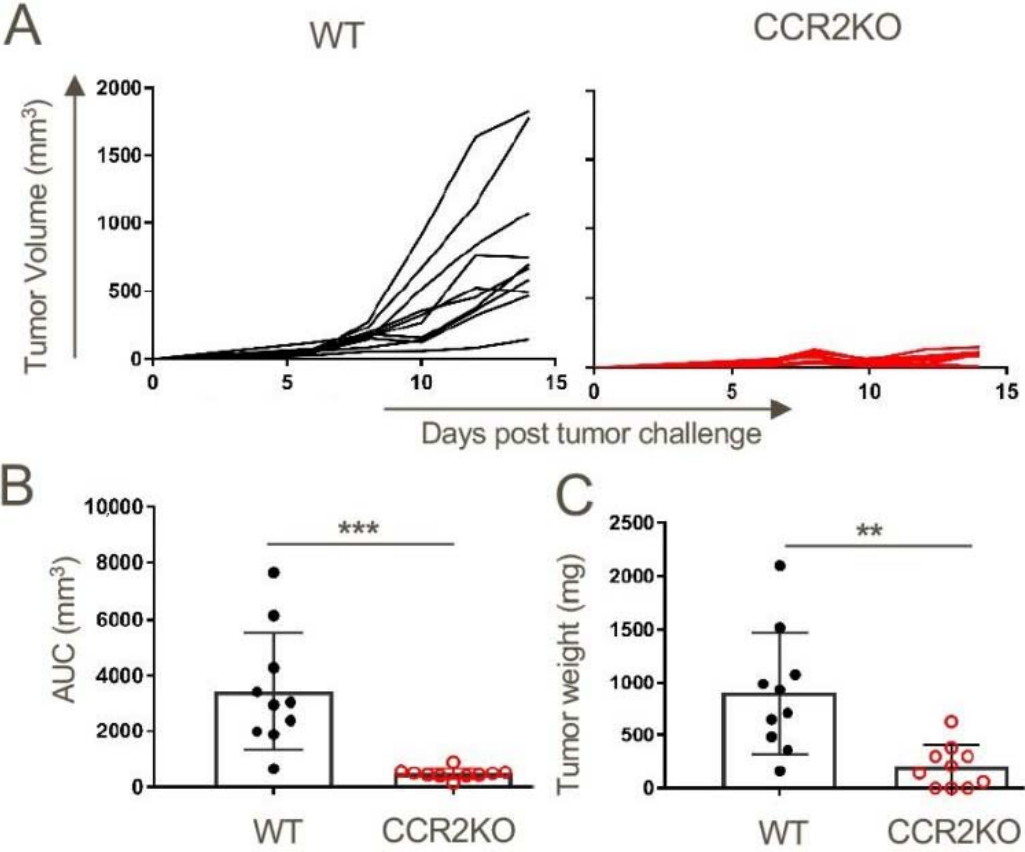
Figure 2. Growth of subcutaneously transplanted TC1 mouse lung tumors is dependent on CCR2 signaling. TC1 tumor cells (1 × 10 6 ) were injected subcutaneously into WT and CCR2KO mice. ( A ) Tumors were measured biweekly until they were harvested on day 14 post-tumor inoculations, when ( B ) tumor volumes and ( C ) tumor weights were determined; ** p < 0.1 and *** p < 0.001, n = 10/group. Data are representative of three independent experiments.